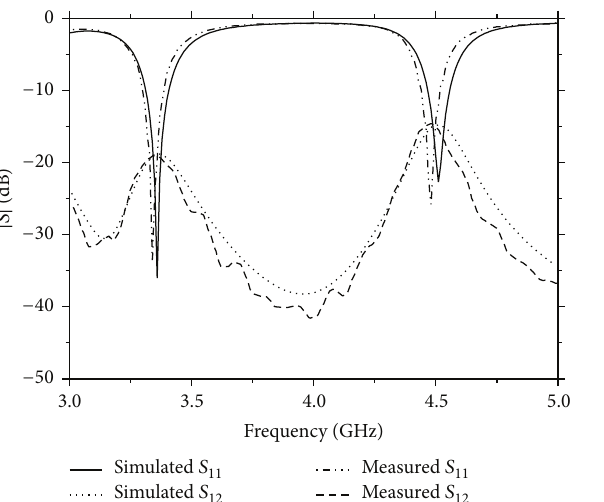
Figure 8: The 𝑆 -parameters of the patch array without DGS.